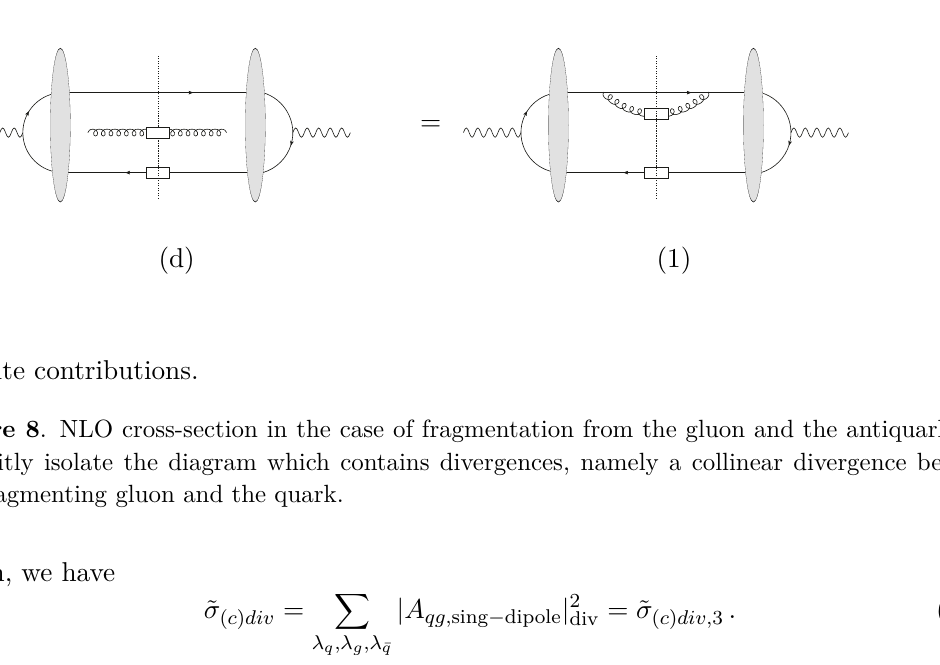
Figure 7 . NLO cross-section in the case of fragmentation from the gluon and the quark. We explicitly isolate the diagram which contains divergences, namely a collinear divergence between the fragmenting gluon and the antiquark.